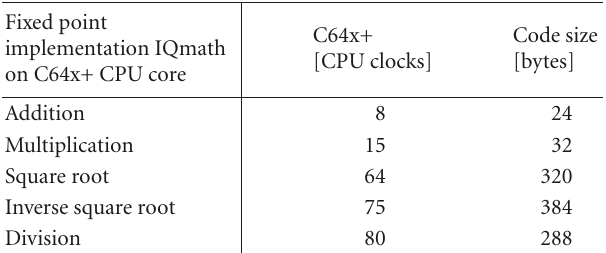
Table 3: Cycle count and code size for floating point emulation of the key operations for numerical linear algebra (fixed point C64x+ CPU).